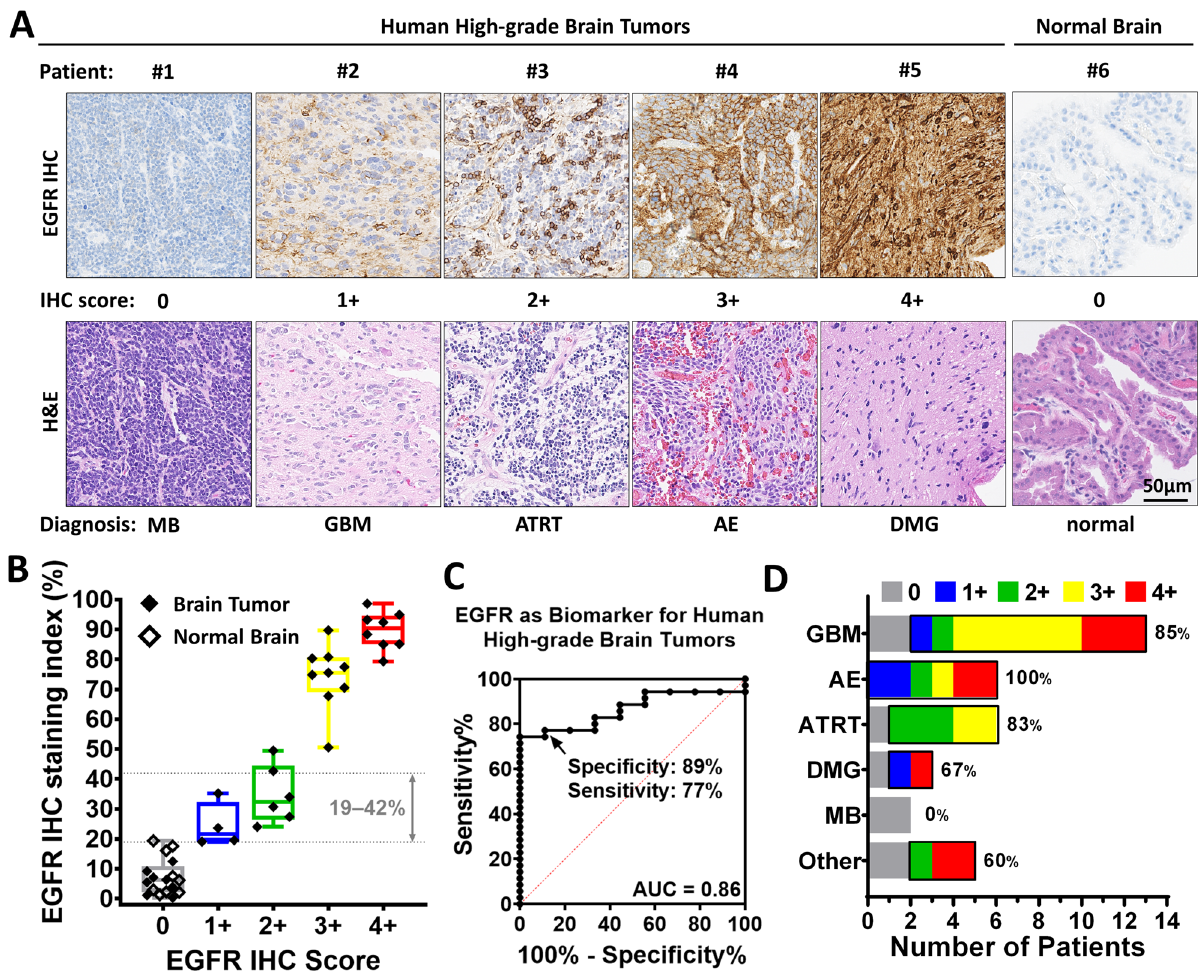
Figure 5. EGFR expression across human high-grade brain tumors. ( A ) Representative microscopic images of EGFR IHC staining scored as 0, 1 +, 2 +, 3 + and 4 + by neuropathologists on human high-grade brain tumor and normal brain tissue sections. H&E: corresponding histology staining of each tissue. MB: medulloblastoma; GBM: glioblastoma multiforme; ATRT: atypical teratoid rhabdoid tumor; AE: anaplastic ependymoma; DMG: diffuse midline glioma. ( B ) EGFR IHC staining index quantified from HGG patient tissues in ( A ). ( C ) EGFR distinguished human HGG tumor from normal brain as a biomarker in ( B ) with 89% specificity and 77% sensitivity. AUC: area under the curve; ROC: receiver operating characteristic. ( D ) Percentage of patients with EGFR positive expression (scored 1 + to 4 +) in high-grade brain tumor disease subtypes. GBM ( n = 13), AE ( n = 6), ATRT ( n = 6), DMG ( n = 3), MB ( n = 2) and other: anaplastic astrocytoma (4 +, n = 1), pleomorphic glial neoplasm (4 +, n = 1), anaplastic oligodendroglioma (2 +, n = 1), ganglioneuroblastoma (0, n = 1) and anaplastic ganglioglioma (0, n =